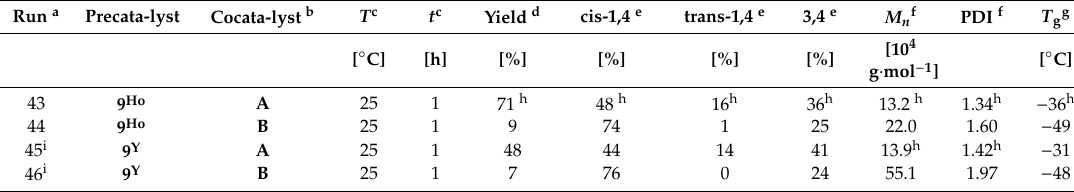
Table 8. Isoprene homopolymerization by [(Cp*Ho) 3 Me 4 (CH 2 )(thf) 2 ] ( 9 Ho